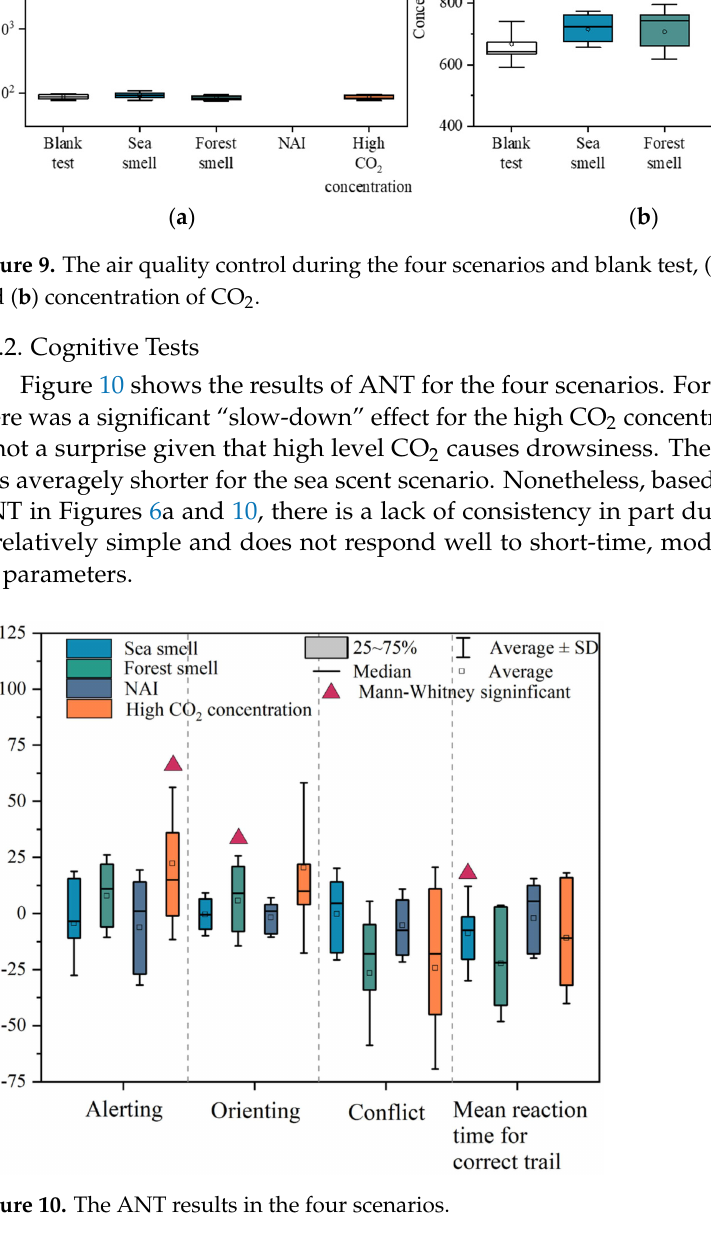
9 of 14 Figure 8. The Profile of Mood States (POMS) scores after natural and indoor exposure.